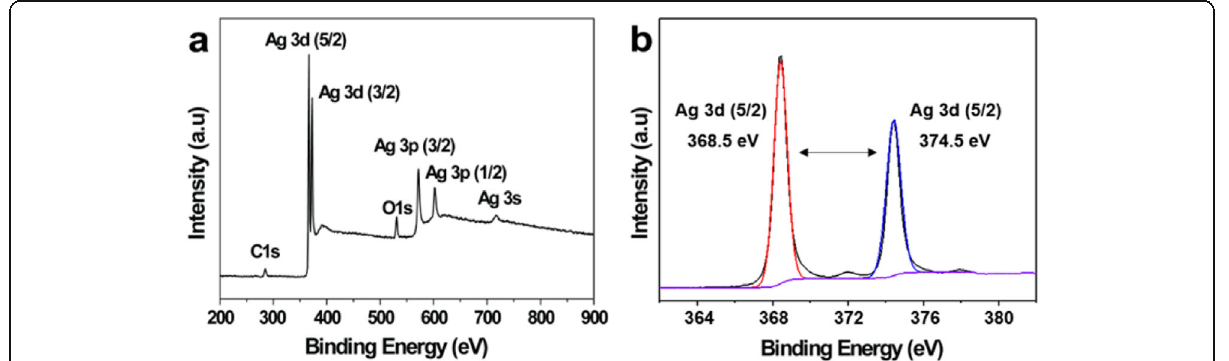
Fig. 4 a The full scan of XPS spectrum of Ag NPs and b the Ag 3d XPS